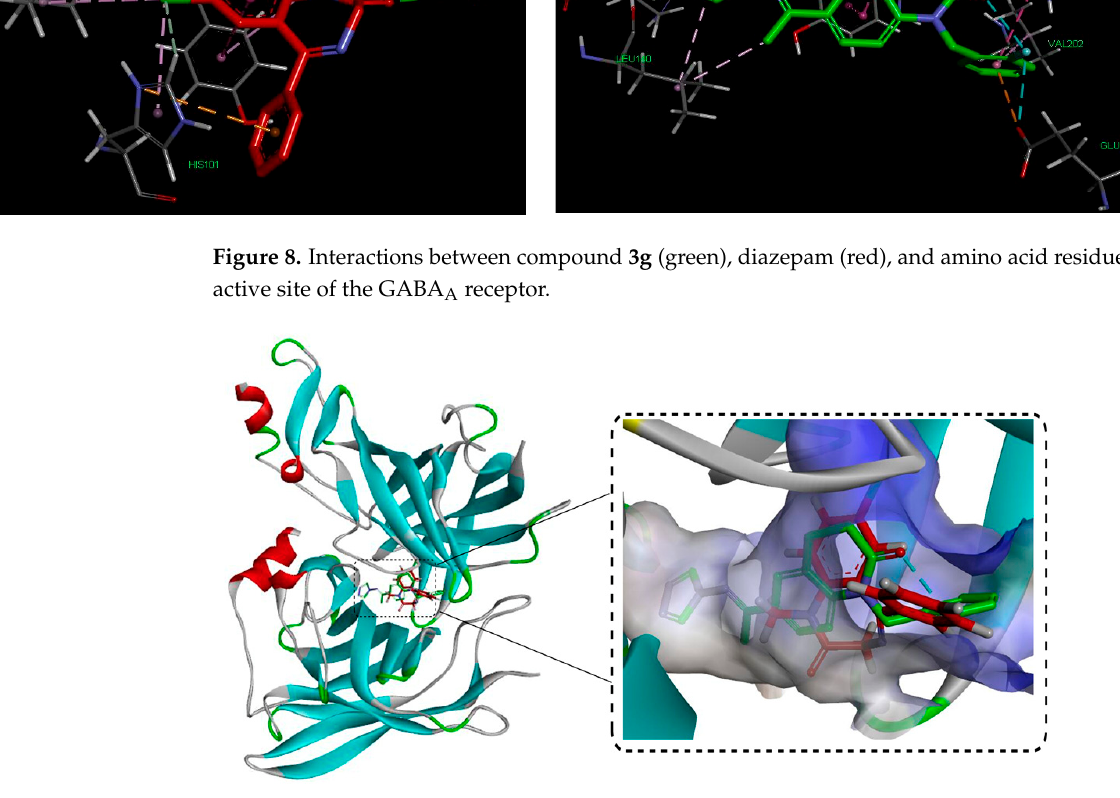
Table 3. Drug-like property parameters of the target compounds 3a – l .